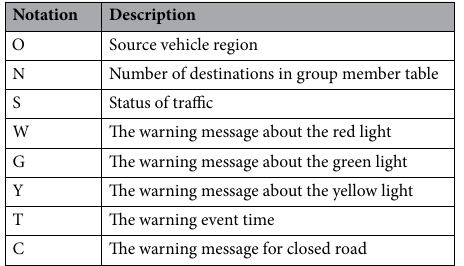
Table 3. Notations of Algorithm 2 and their